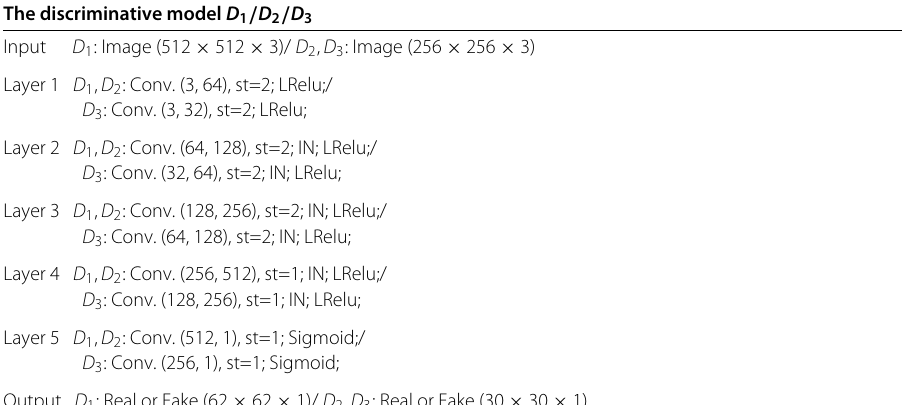
Table 2 The architecture of D 1 / D 2 / D 3 network. Annotations are the same as Table 1. The different layers of D 1 , D 2 , and D 3 are listed separately The discriminative model D 1 / D 2 / D